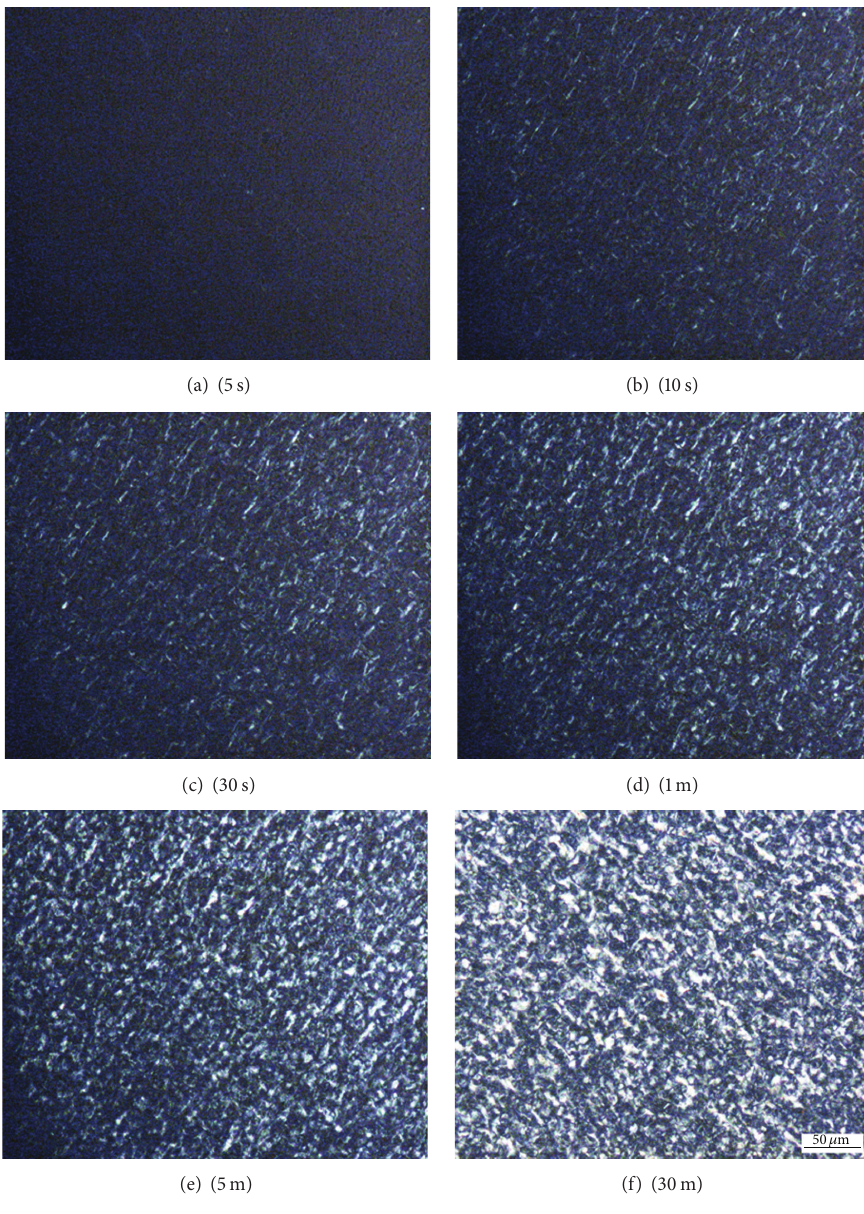
Figure 4: POM micrographs of